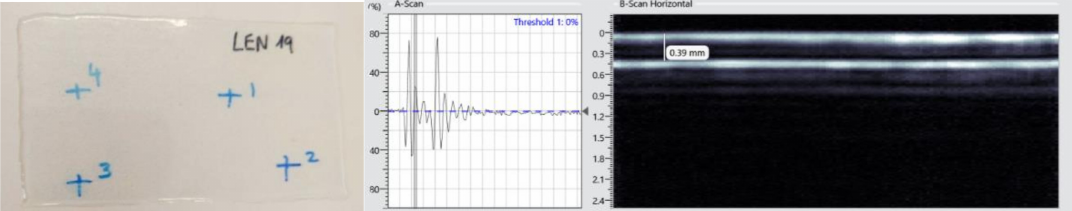
Figure 2. (Left) Thin Coating LEP used for UT coupon, (Right) Example of how a Time of Flight measurement is used in a tested